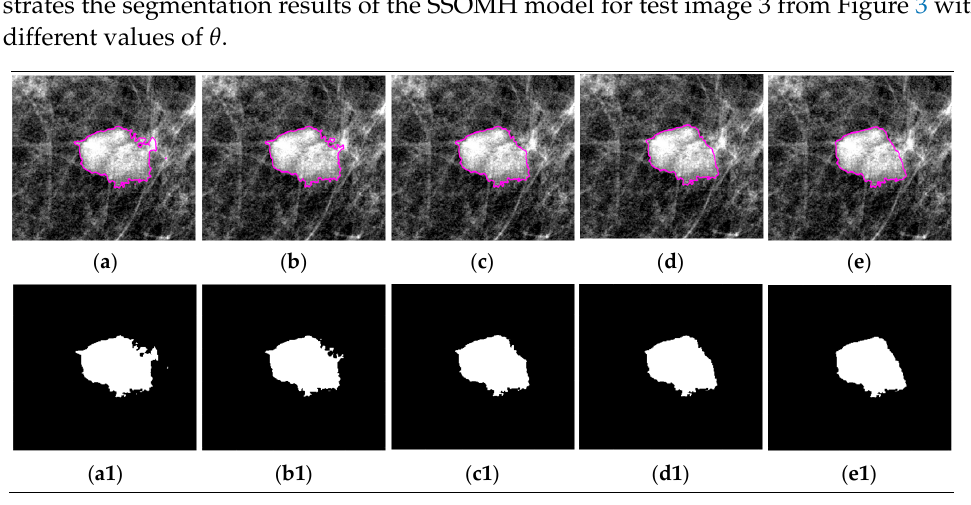
Figure 8. Performance Evaluations of the SSOMH Model with Different Values of θ . Figure 8 shows the JSC, DSC, Accuracy and Error metrics for different values of 𝜃 . It can be observed that the image with 𝜃 = 1000 has the highest JSC, DSC and Accuracy values with the lowest Error values, indicating more accurate segmentation results com- pared to the images with the other 𝜃 values shown above. Thus, the values of 𝜃 should